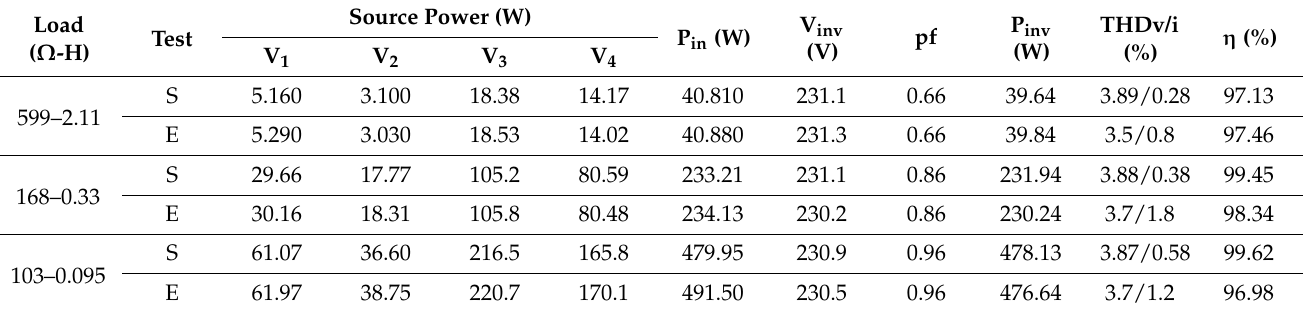
Table 8. Simulation (S) and experimental (E) tests of the full system with 17 L inverter under RL loads.